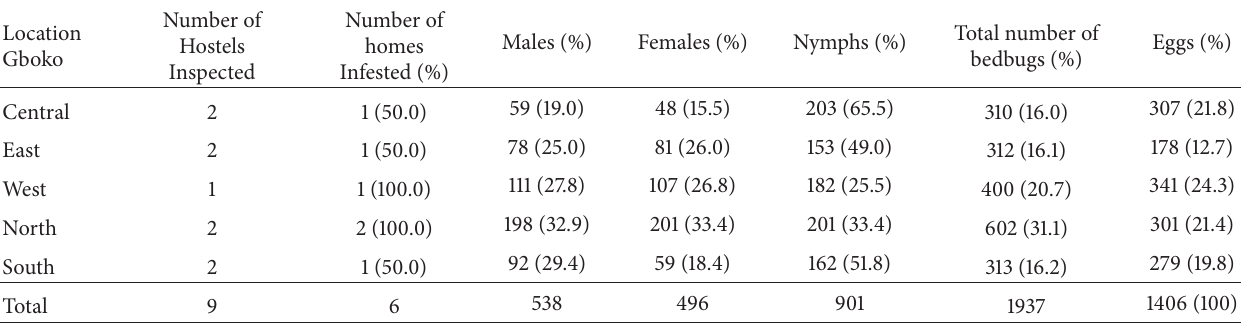
Table 2: Sex and growth stage of bedbugs ( Cimex lectularius ) collected from Hostels in Gboko. Location